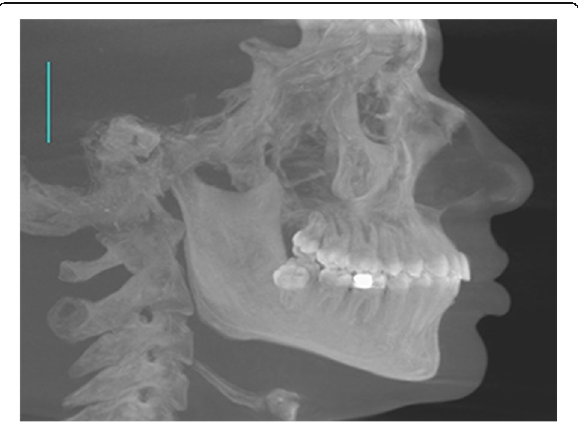
Fig. 1 CBCT-synthesized lateral cephalometric